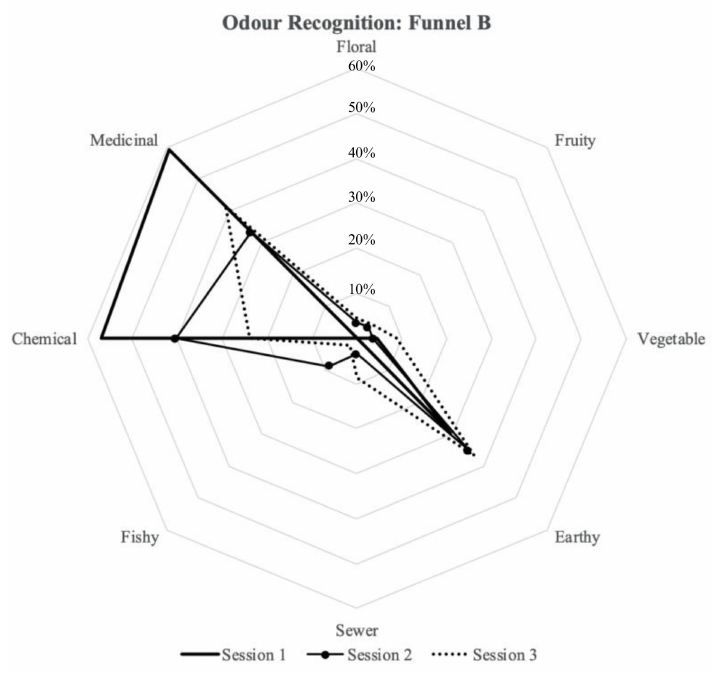
Figure 11. Odor recognition assessment for Chamber B. Table 5. Preference assessment for the two chambers in the three